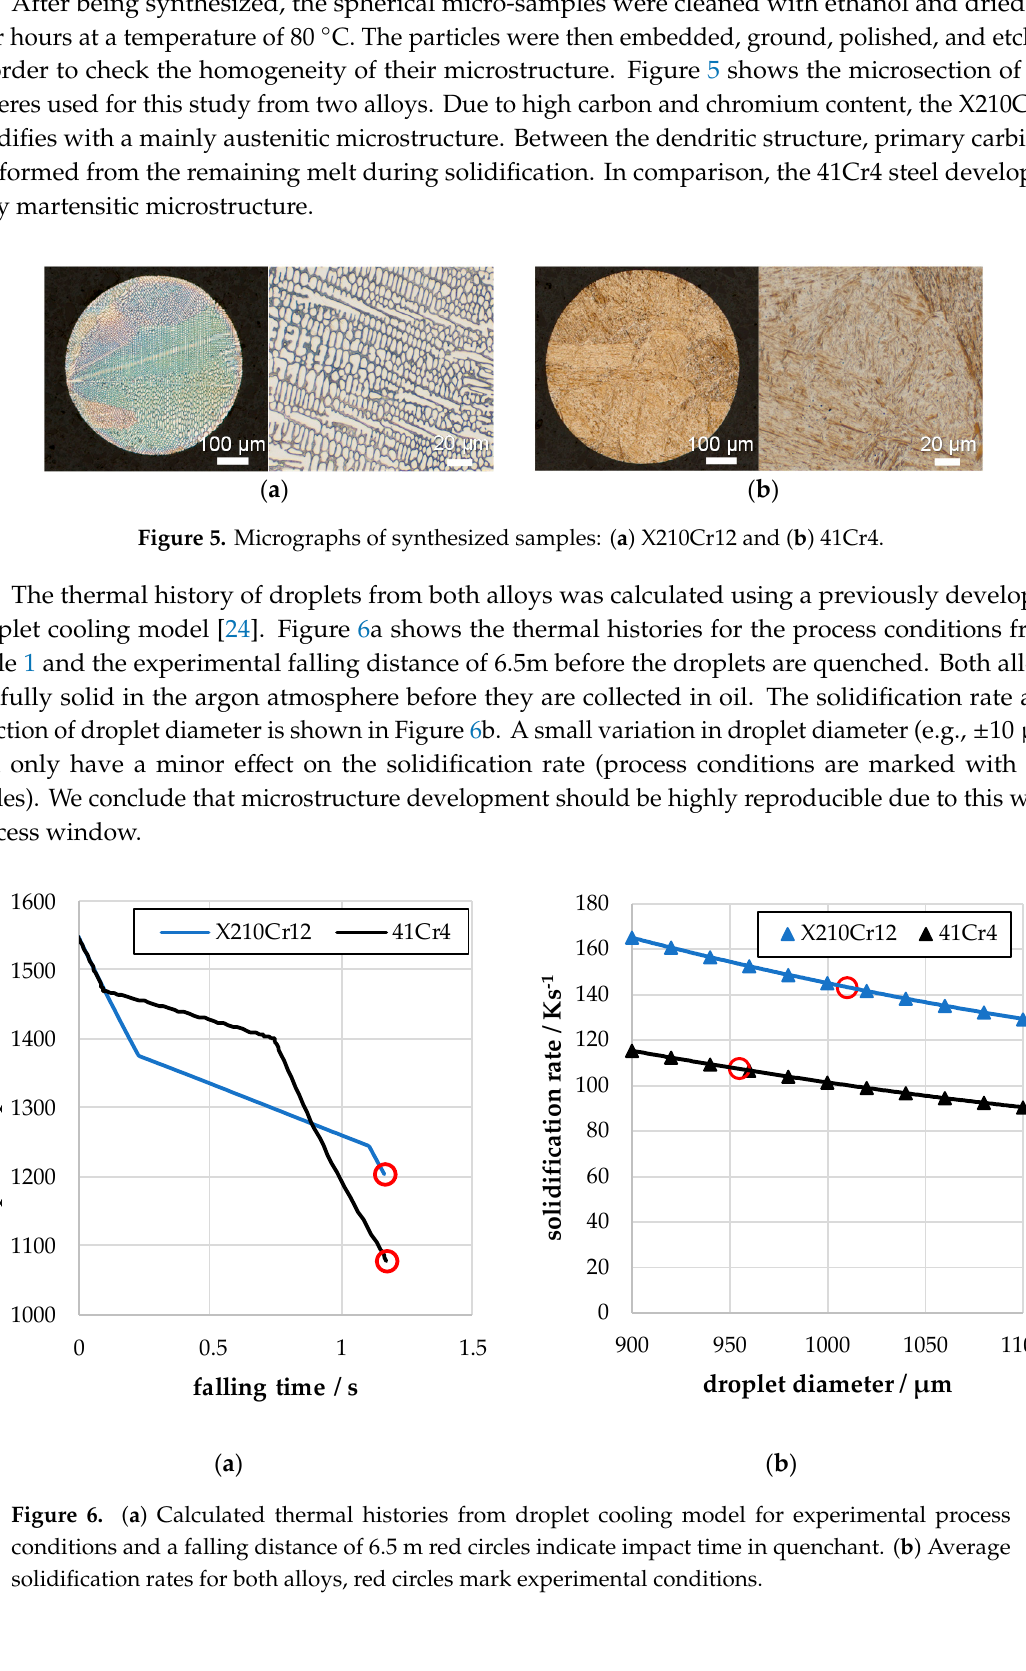
Figure 4. Linear Sweep Voltammetry (LSV) measurement in 0.1 M phosphate buffer with 0.1 M NaCl. Scan rate: 0.001 Vs − 1 . Corrosion current determined by the Tafel method and corrosion potential are marked.